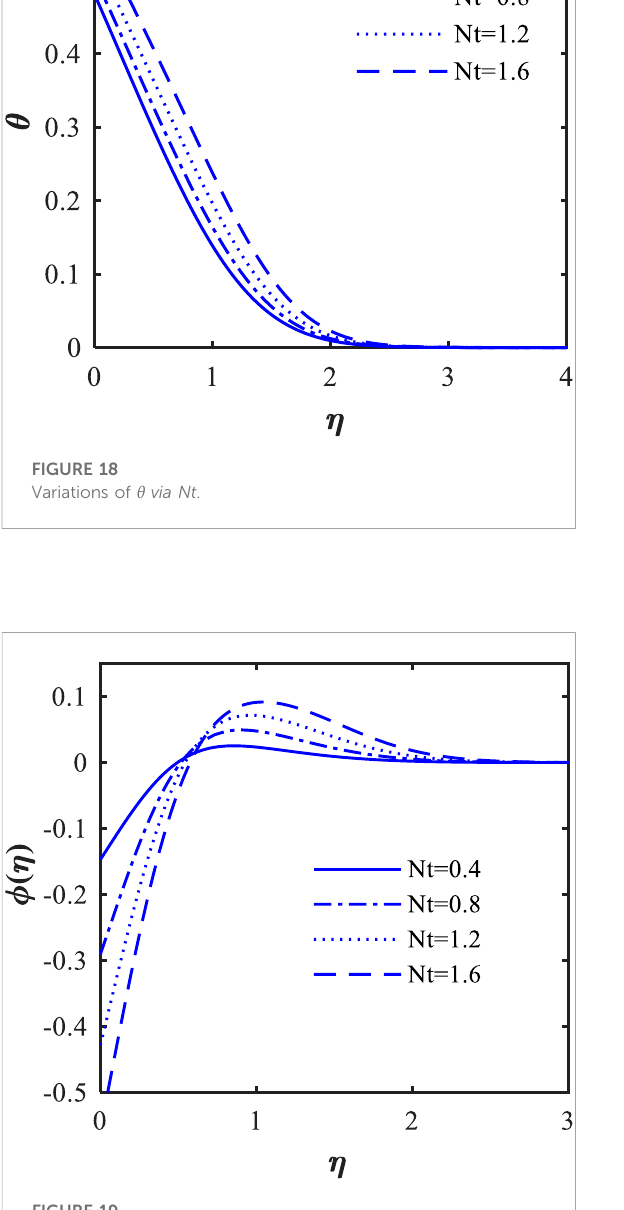
FIGURE 19 Variations of ϕ via Nt .